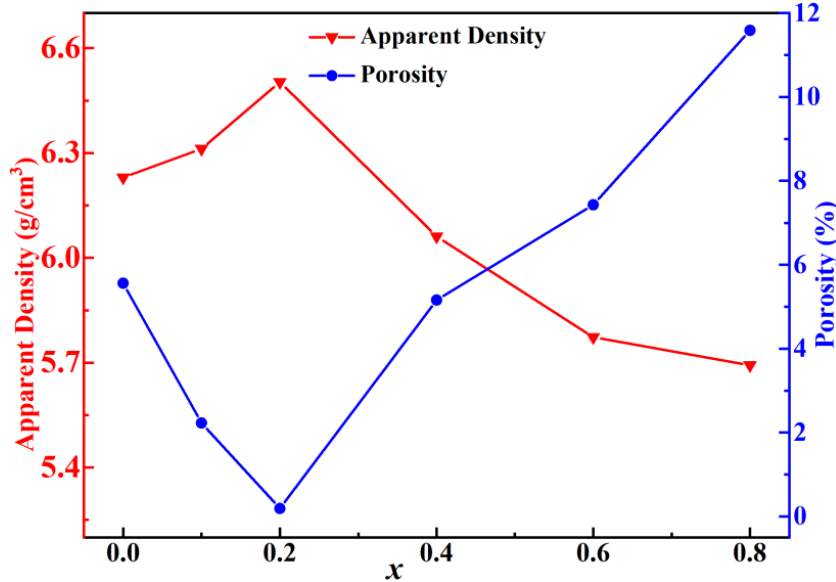
Figure 9. The variation of apparent density and porosity with x from 0 to 0.8.